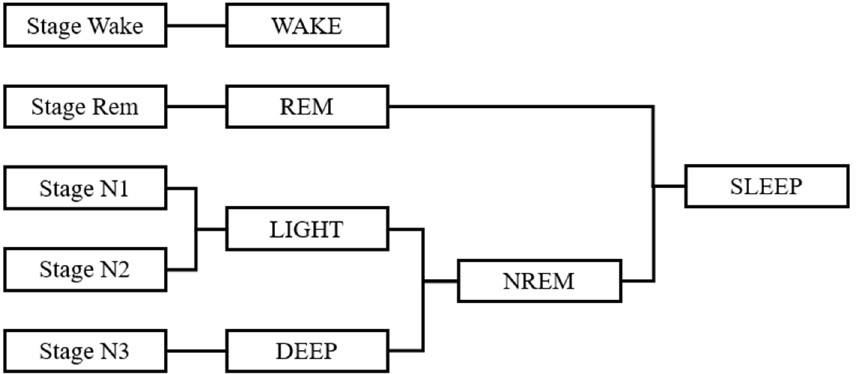
Figure 2. Classification of sleep stages.